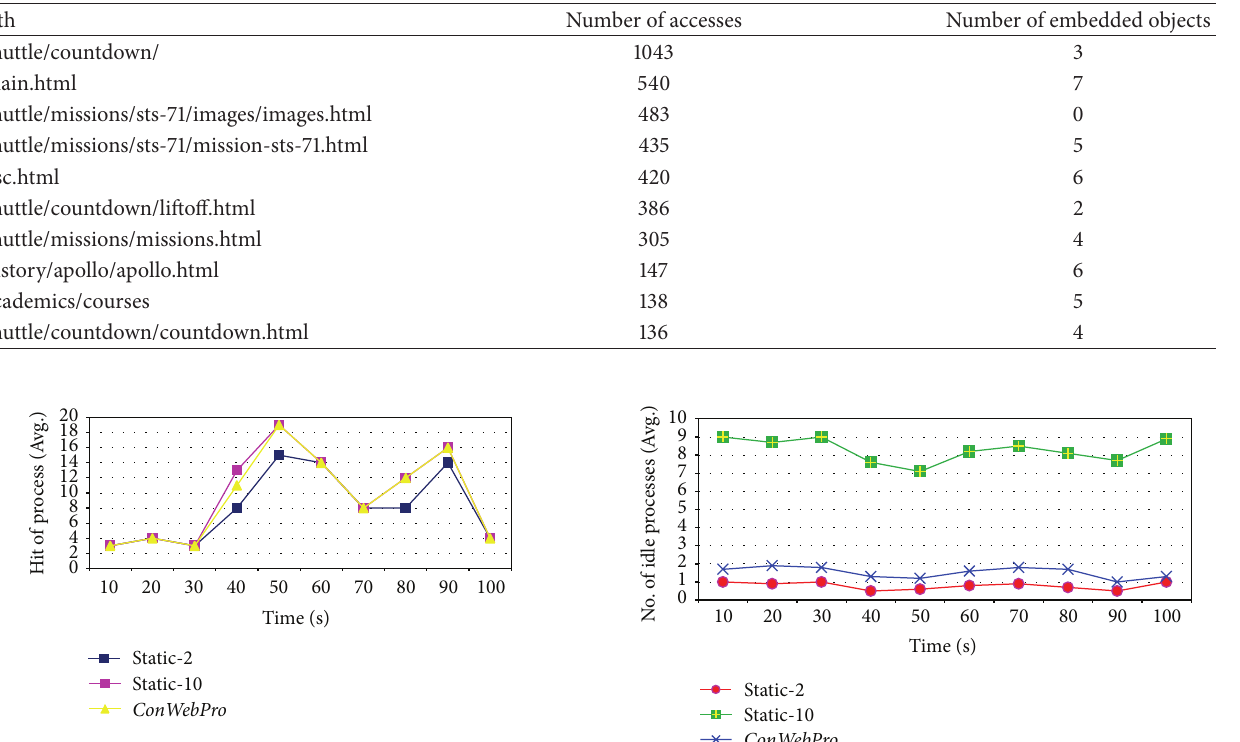
Figure 8: The average hit request at NASA web traces.